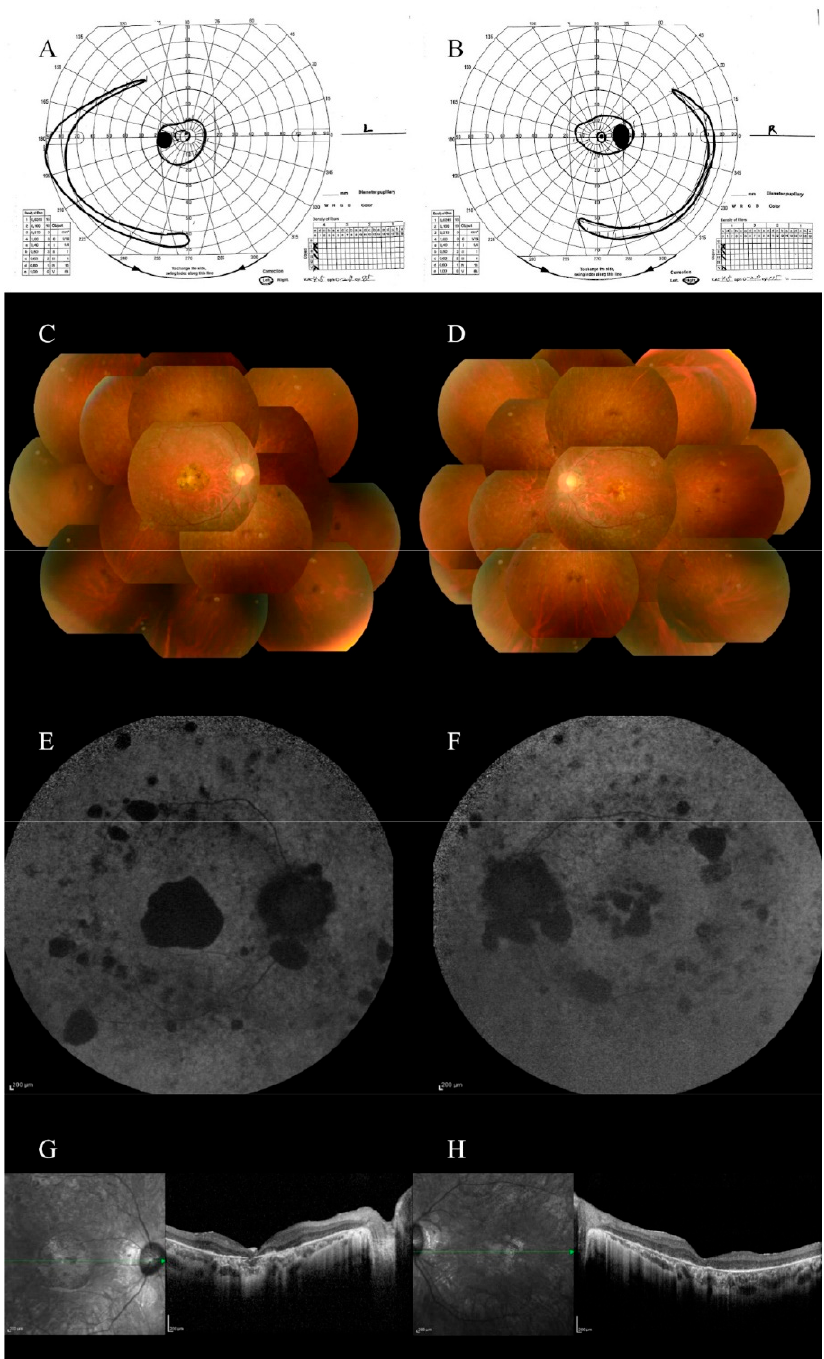
Figure 3. Clinical features of case 2. The visual field examined at the age of 26 years: ( A ) left eye; ( B ) right eye. The visual field was constricted. Fundus photograph obtained at the age of 26 years: ( C ) right eye; ( D ) left eye. Fundus photography showed poor retinal color and narrowing of the retinal blood vessels. FAF obtained at the age of 31 years: ( E ) right eye; ( F ) left eye. FAF showed low fluorescence, consistent with retinal degeneration. OCT images obtained at the age of 31 years: ( G ) right eye; ( H ) left eye. OCT images showed that the retina was highly thinning, and the EZ line could not be observed at all.